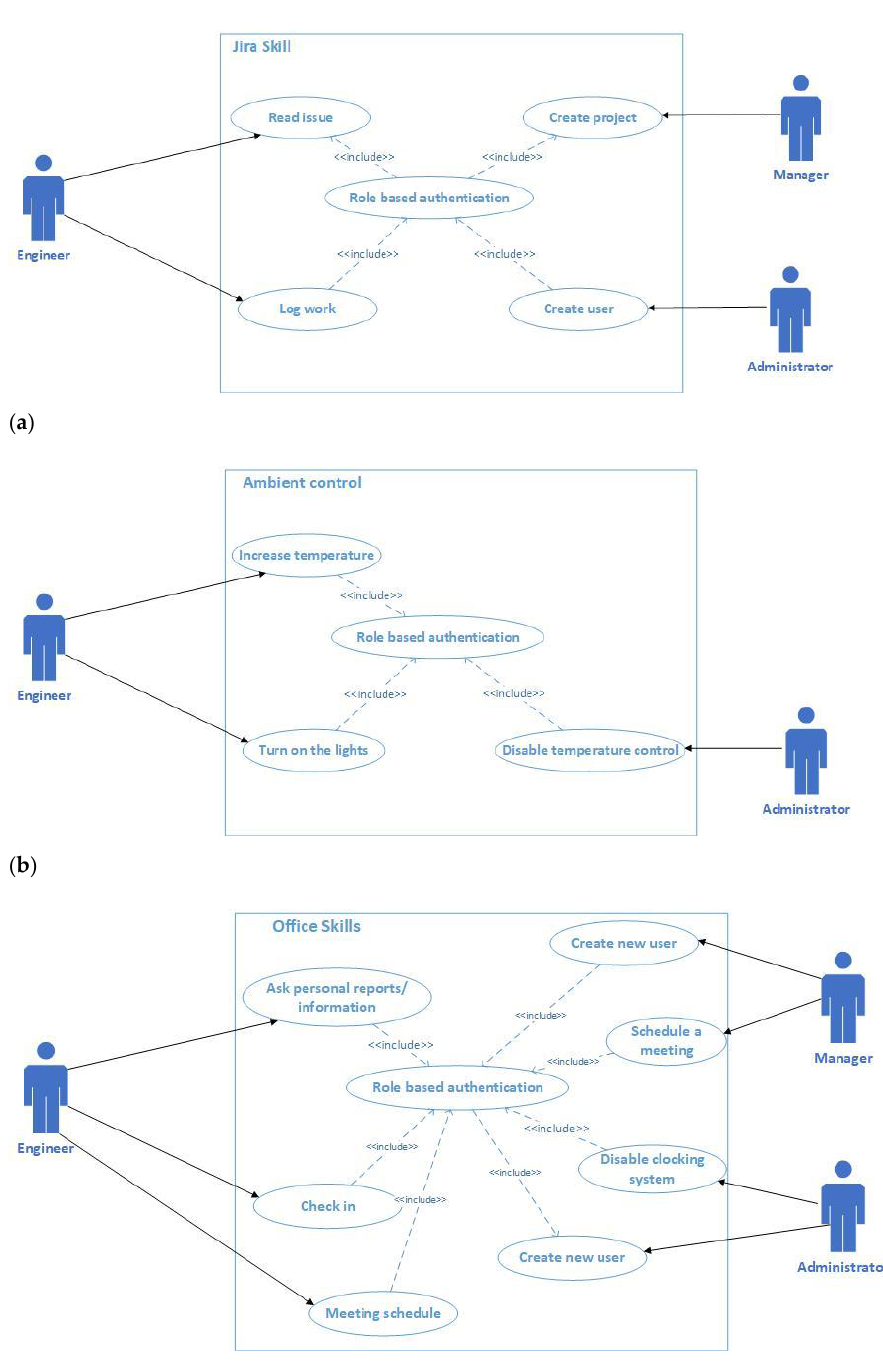
Figure 1. ( a ) Jira skill use case; ( b ) Ambient control use case; ( c ) Office skill use case.